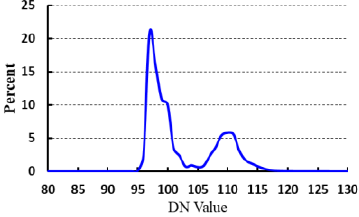
Figure.7 Histogram of DN value in thermal infrared band of Landsat-5 satellite image.